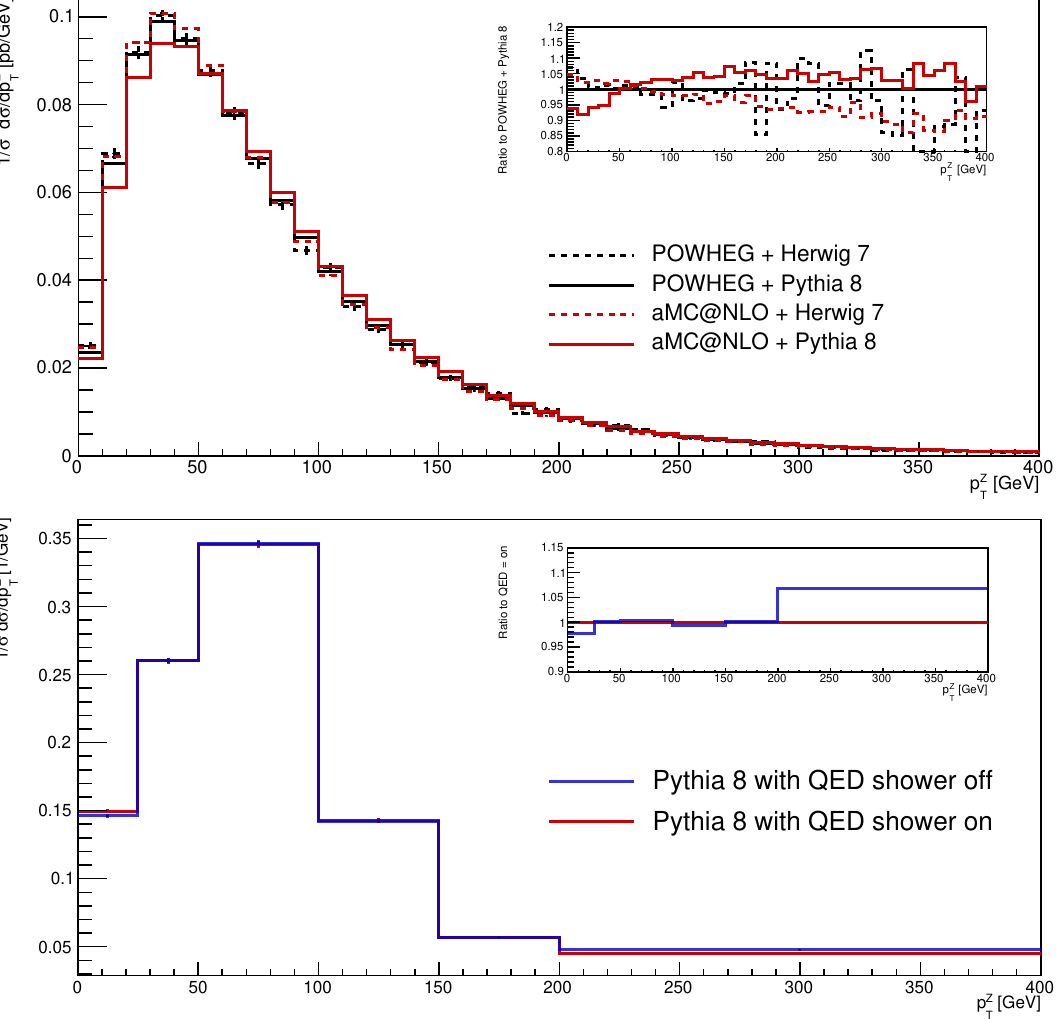
Figure 12 . Normalised Z p T spectra for studying shape variations in SM WZ production. Above, the e(cid:11)ect of changing the event generator and parton shower program. Below, the approximate e(cid:11)ect of EW corrections determined by switching photonic emissions on and o(cid:11) in Pythia 8 . di(cid:11)erent combinations of event generators and parton shower programs were determined using the central scale cases for both aMC@NLO as well as POWHEG , and the nominal Pythia 8 and Herwig 7 setups. The normalised Z p T spectrum for the four di(cid:11)erent combinations can be seen in the top of (cid:12)gure 12. Here, the nominal case can be thought of as POWHEG + Pythia 8 , since both ATLAS and CMS use this for their measurements. The biggest deviation from the nominal is therefore aMC@NLO + Pythia 8 , the reason of which is unclear. However, it can be said that changing from POWHEG to aMC@NLO would have accentuated the apparent excess at low Z p by an unrealistic amount. Therefore, it was decided that T POWHEG + Pythia 8 models the SM W Z production the best, and so this prediction was used in the